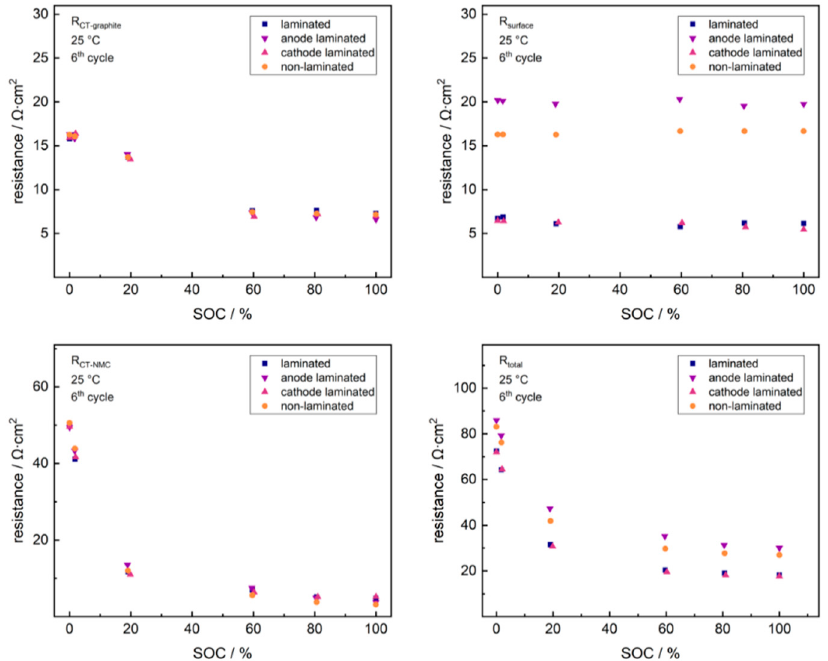
Figure 4. EIS resistance fit parameters of laminated / partially laminated / non-laminated cells along charging step, sixth cycle; data normalized to geometric electrode area.